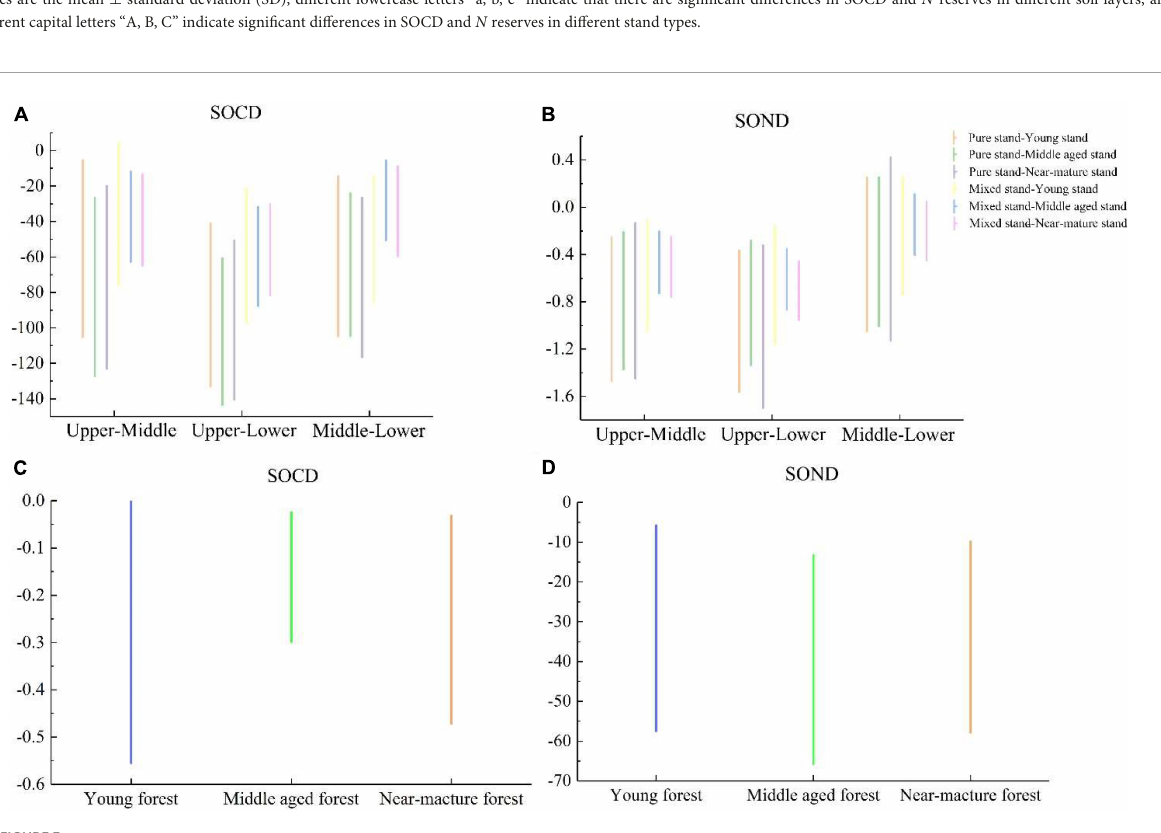
FIGURE3 Analysis of variance results. (A) 95% family-wise confidence level for SOCD in different age groups in different soil layers; (B) 95% family-wise confidence level of SOND in different age groups; (C) 95% family-wise confidence level of SOCD in mixed and pure P. massoniana